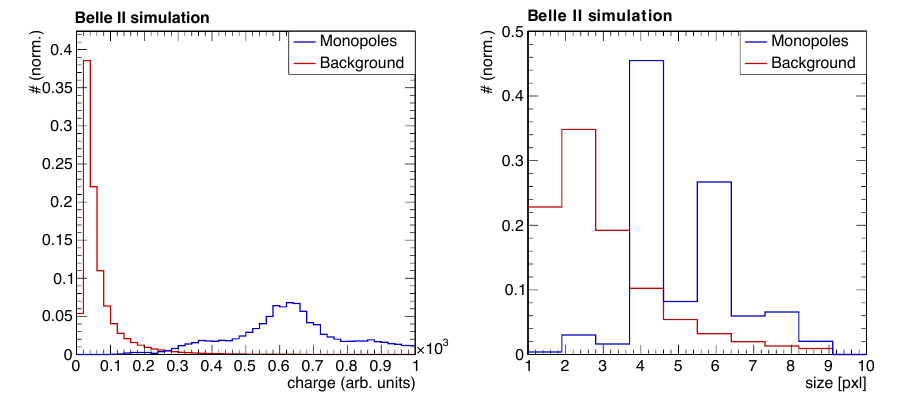
Figure 2: Cluster charge and cluster size for magnetic monopoles and beam background. Clusters generated by monopoles tend to be significantly higher in charge and size compared to clusters formed by background particles.